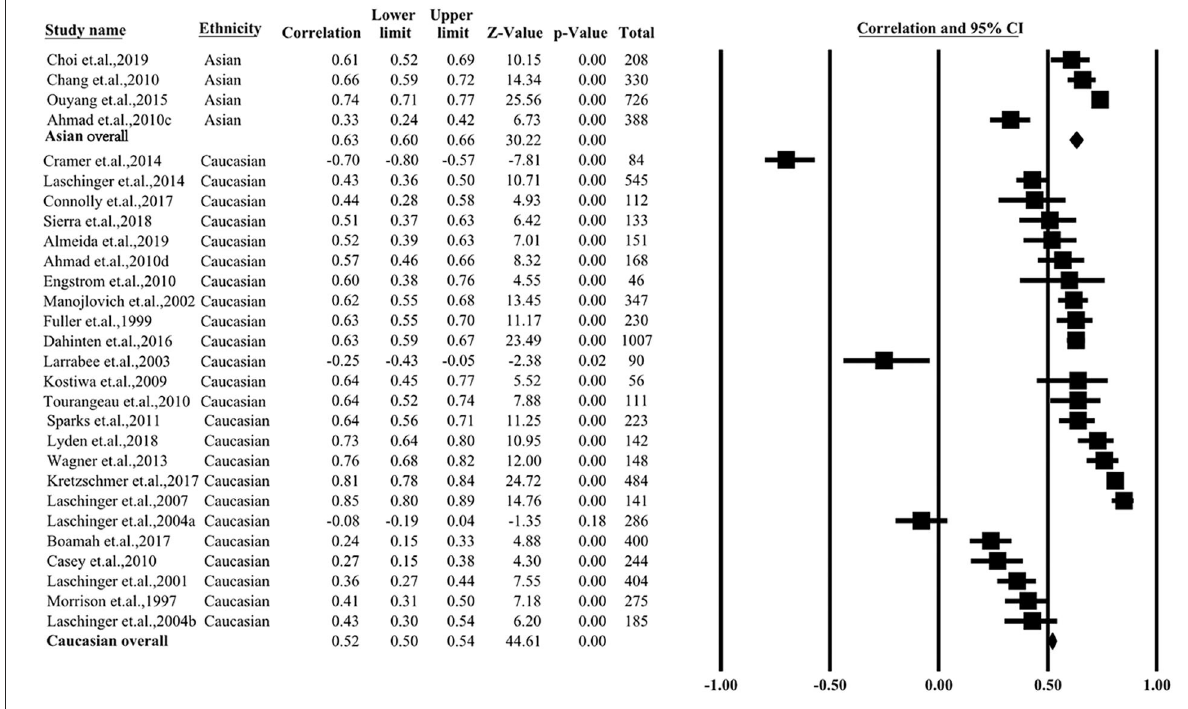
FIGURE3 Summarized overall correlation categorized by